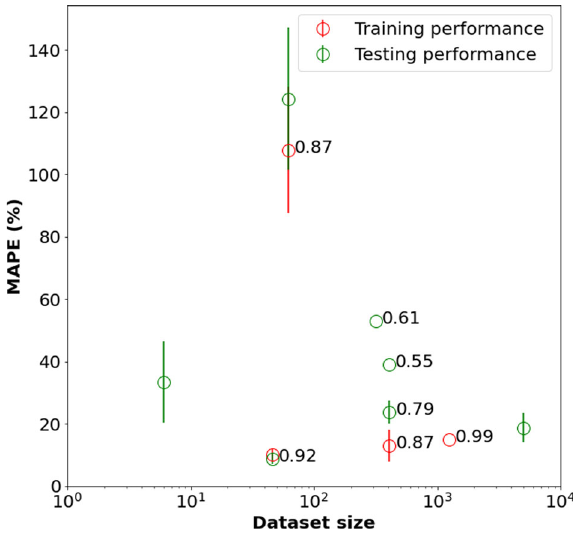
Fig. 3 The mean MAPE as a function of the ‘ Dataset size ’ (for both training and testing datasets). Corresponding mean R² were included whenever possible next to data points. This plot considered all corrosion topics from the ML for corrosion database 43 . The error bars represent the standard deviation of the